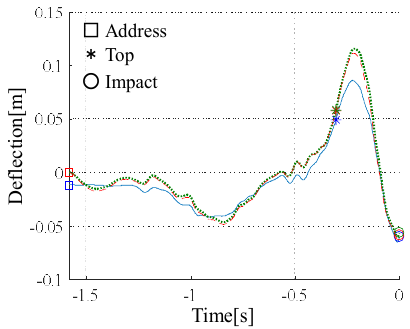
Figure 9. Comparison of measured and simulated results of deflection in the toe direction.